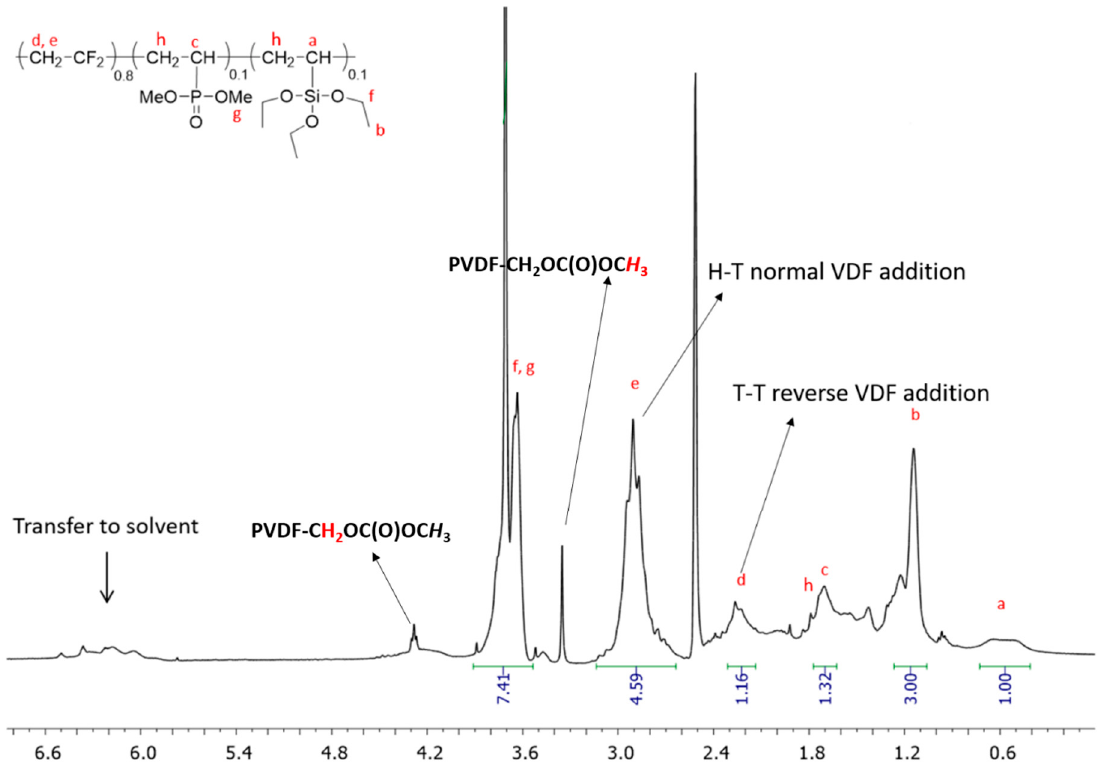
Figure 1. 1 H NMR spectrum of poly(VDF- ter -VTEOS- ter -VDMP) terpolymer ( P 20 , Table 1), recorded in DMF- d 7 at 20 °C.